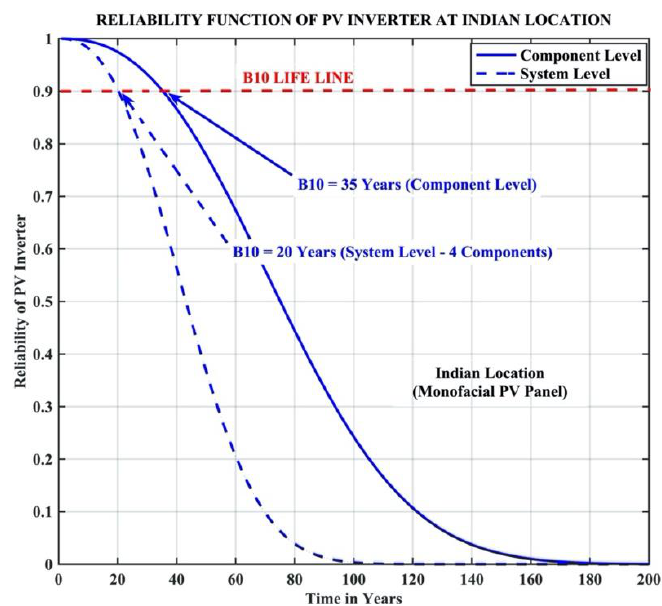
Figure 13. Reliability function of the PV inverter at the location in India.